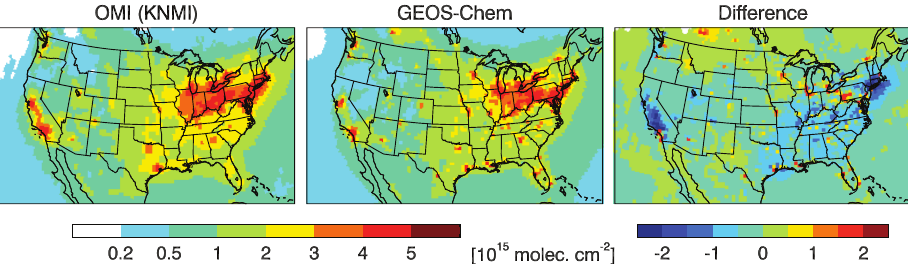
Fig. 6. Mean tropospheric NO 2 columns in March-November 2006. OMI satellite observations mapped on the 1/2 ◦ × 2/3 ◦ GEOS-Chem grid (left) are compared to GEOS-Chem results (center). The GEOS-Chem minus OMI difference is shown in the right